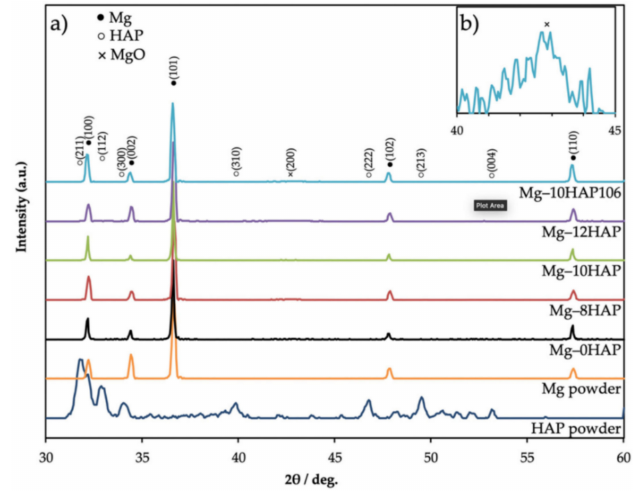
Figure 4. XRD results of Mg, HAP powder, and Mg-xHAP composites ( a )XRD pattern; ( b ) Extended view of Mg-10HAP106 within 40–45 ◦ [51].